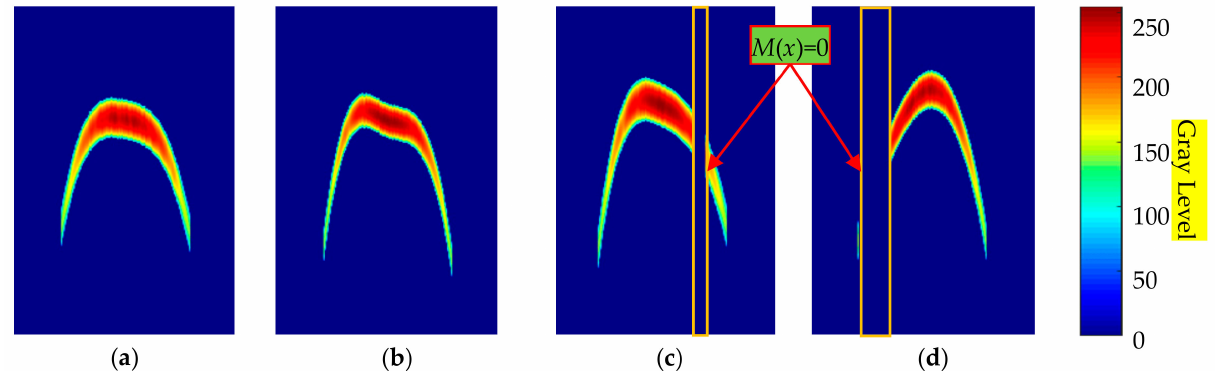
Figure 15. Pipeline images after applying various factors. ( a , b ) are only influenced by the heave of the carrier platform; ( c , d ) suffer both the heave of the carrier platform and missing effective pipeline echoes.